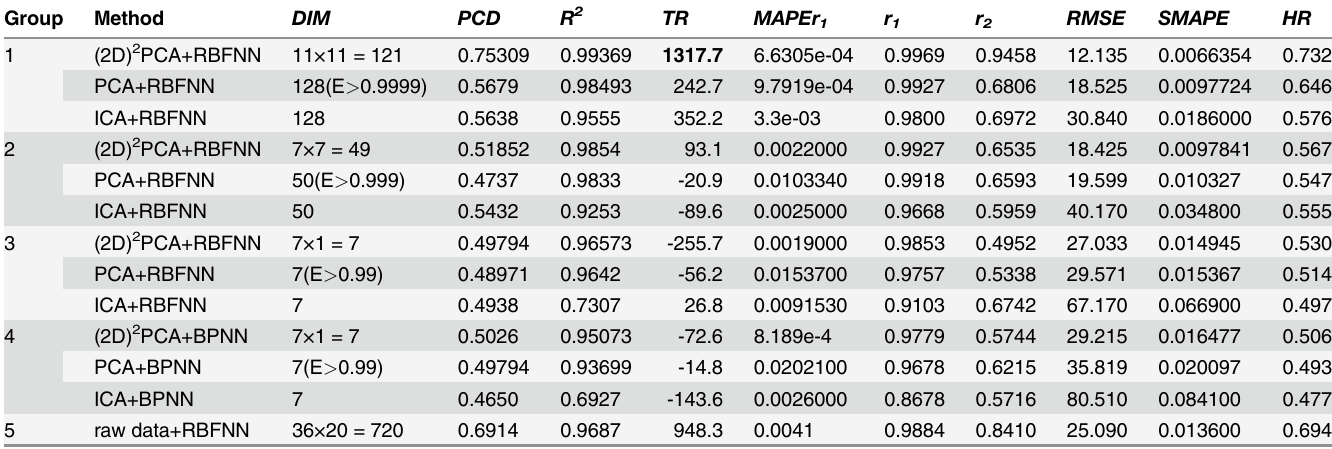
Table 3. Nine measure indicators of ICA, PCA and (2D) 2 PCA associated with RBFNN and BPNN under different dimension. Group